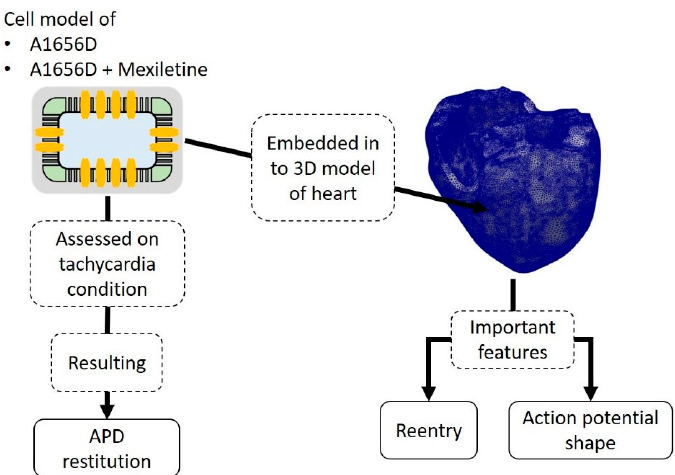
Figure 1. Diagram of the simulation protocol of single cell and 3D model of the heart.